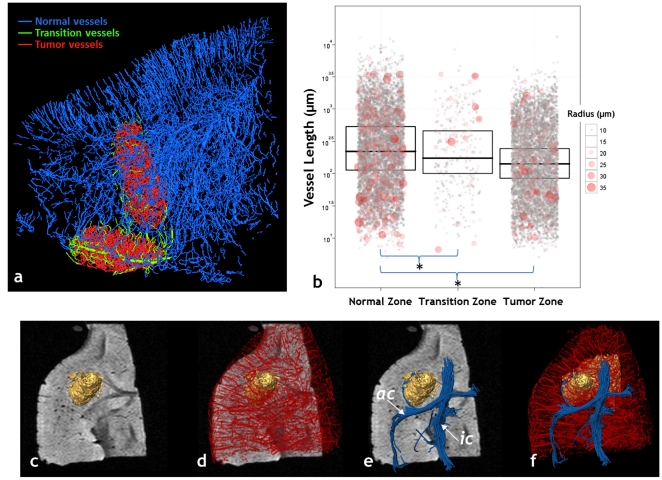
Ultra-high resolution 3D μMRI and “zonal” analyses of the neurovasculature.(a) 3D rendering of the neurovasculature in a non-invasive, 9L tumor bearing mouse brain acquired using ultra-high resolution (30 µm×30 µm×30 µm) μMRI. The vasculature has been color coded into three different “zones”: normal vessels (blue), tumor vessels (red) and vessels at the tumor-brain interface or transition zone (green). The transition-zone or tumor-brain tissue interface is crucial to understanding both, brain tumor angiogenesis and invasion. The radius and length of every individual vessel segment was measured in each zone. (b) Box plot of the average vessel length in each zone, wherein the width of each box includes 75% of the measured lengths and the median length is indicated by a horizontal line in each box. In addition, the radius of every vessel segment is plotted for each zone, with the color and size of each symbol proportional to the vessel radius. The normal zone exhibited significantly longer vessel segments compare to the transition (p = 0.002) and tumor zones (p<0.001), respectively. At this tumor stage, vessel radii were similar between the tumor and normal zones. These data demonstrate our ability to characterize the neurovasculature in physiologically relevant “zones”, and could provide new insight into the relationship between brain tumor angiogenesis and invasion. (c) T2-weighted μMRI slice through a 9L brain tumor (gold rendering) bearing brain. (d) 3D overlay of the neurovasculature acquired using ultra-high resolution μMRI. (e) 3D DTI image showing reorganization of the fibers of the anterior commissure (ac) and internal capsule (ic) around the tumor. (f) Overlay of (d) and (e) illustrating simultaneous changes in vascular and white matter structures.